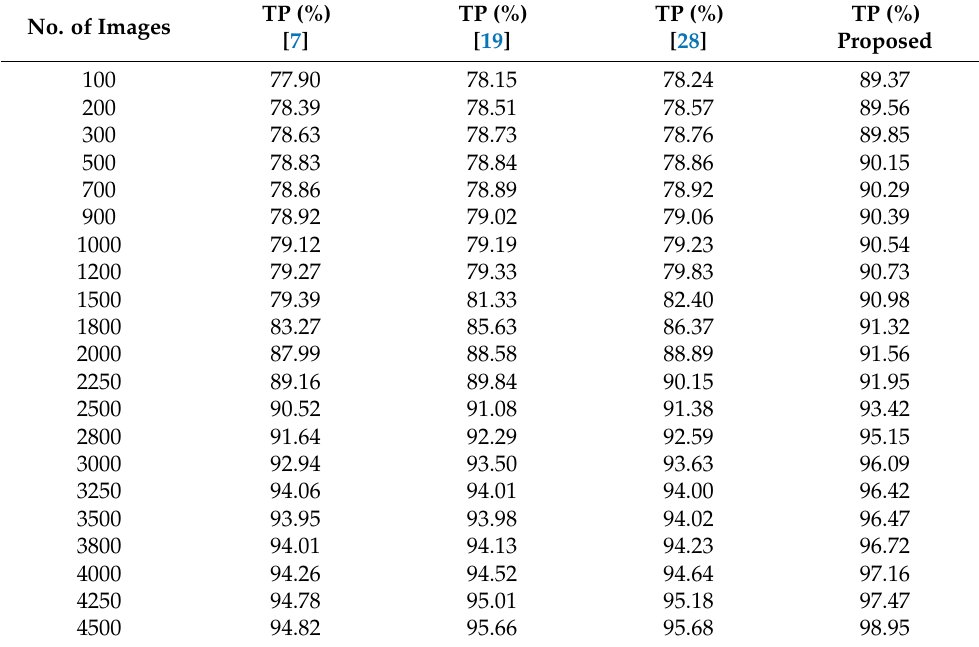
Table 2. Test precision for combined dataset.